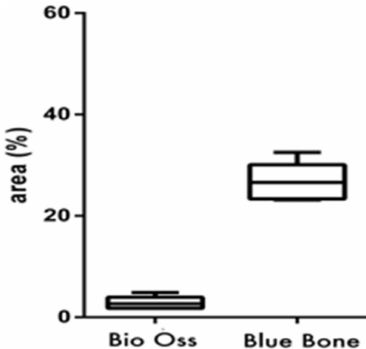
Figure 10. (Graphic 4) Histomorphometric analysis of MMP-9 staining showed that Group 2 (nano-hydroxyapatite / beta-tricalcium phosphate composite) had a larger immunostained area in comparison to that of Group 1 (bone xenograft), ( p = 0.0313).